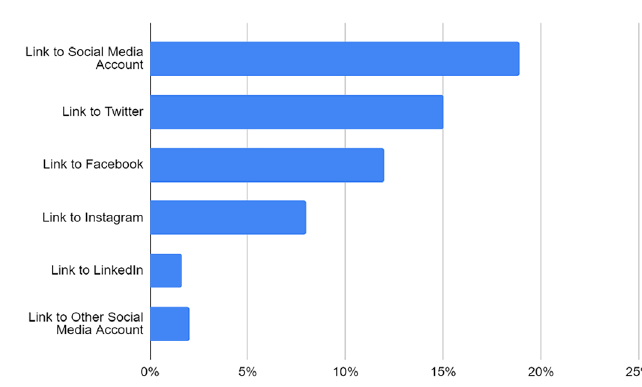
Figure 1. Social media presence of emergency medicine residency